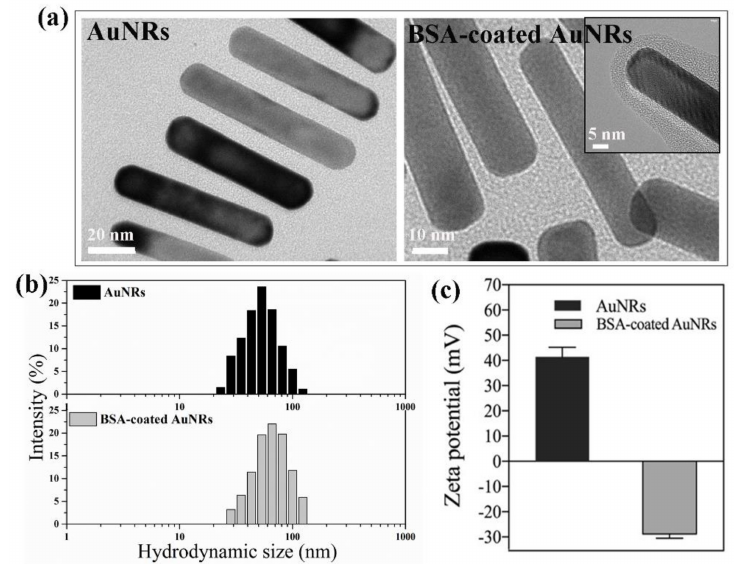
Figure 1. High-resolution transmission electron microscopy images ( a ), hydrodynamic size distribution ( b ) and zeta potential ( c ) of gold nanorods (AuNRs) and BSA-coated AuNRs.